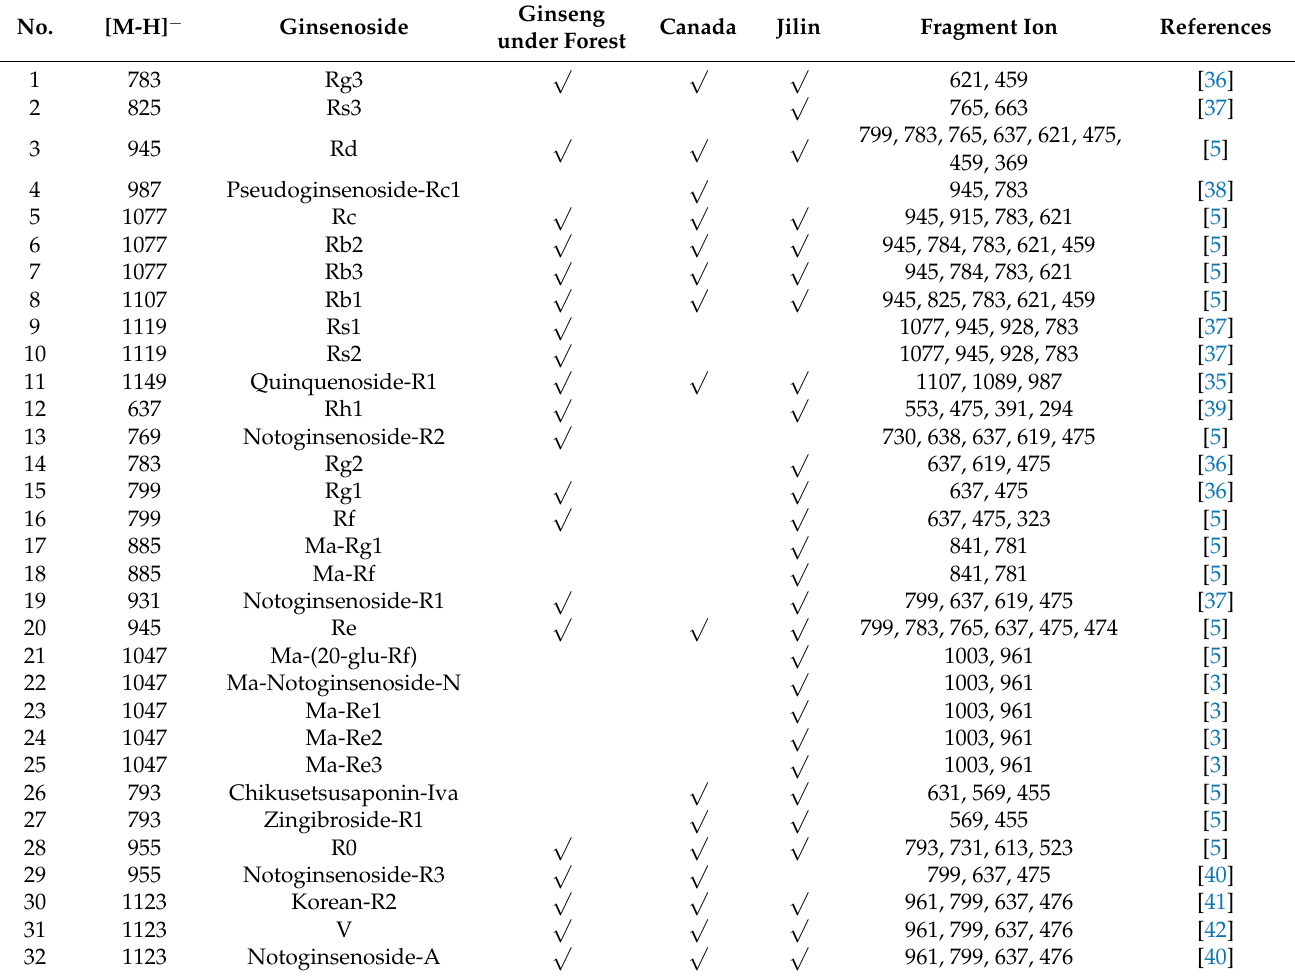
Table 2. Distribution of ginsenosides in the three ginseng